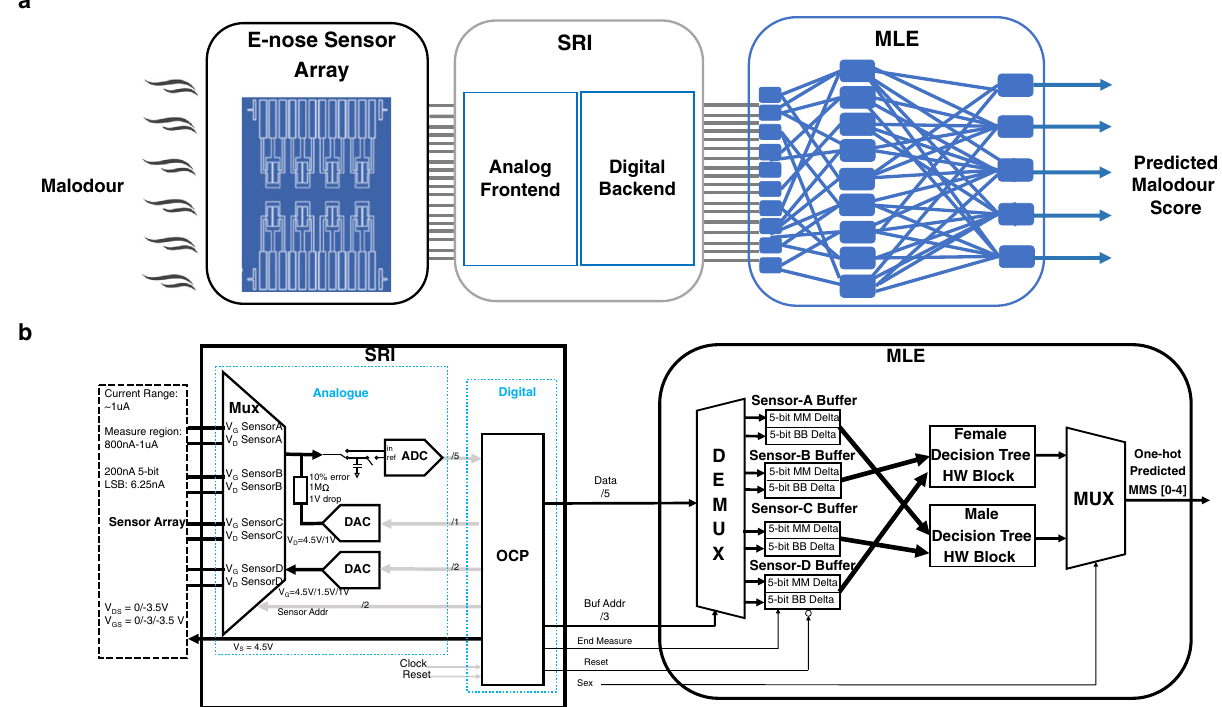
Fig.1|Flexibleintegratedsmartsystem.a Thehigh-levelsystemarchitectureforarmpitmalodourclassi fi cationproblem. b HardwareblocksoftheSRIandMLEusedin the integrated FlexIC are interfaced to the sensor